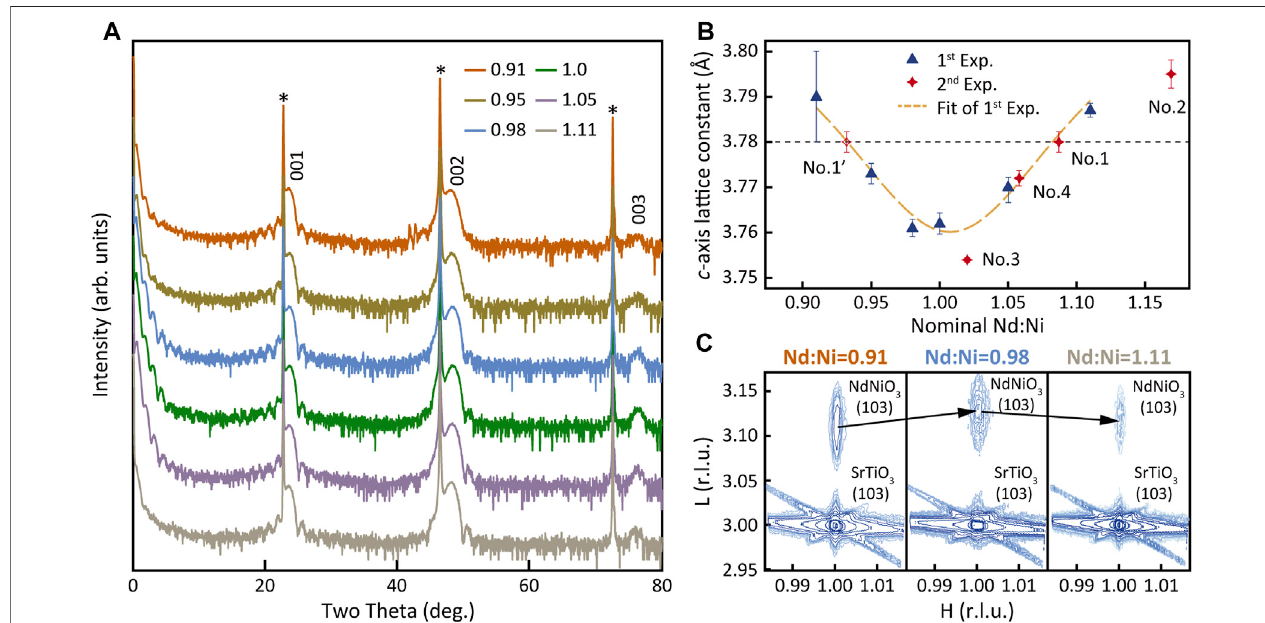
FIGURE 1 | Effect of cation stoichiometry on NdNiO 3 fi lms. (A) XRD 2 θ - ω scans of NdNiO 3 fi lms with different nominal Nd:Ni fl ux ratios. The curves are vertically offsetforclarity. (B) Pseudo-cubiclatticeconstantalongthe( 00l )directionasafunctionofthenominalNd:Ni fl uxratio.Thebluetrianglesandyellowdashedlinerepresent the experimental data and the corresponding Gaussian fi t result, respectively. The red closed stars denote the data points obtained in another set of experiment, accordingtothenumericalordermarkedinthe fi gure,whiletheopenstarisanotherpossiblepositionfortheNo.1sample.Theblackdashedlinedenotesthe c -axis latticeconstantofthe No.1sample.The errorbars come fromthe fi ttingerrorofdiffraction peaks. (C) Reciprocalspacemappings around SrTiO 3 (103) peak forNdNiO 3 fi lms with different fl ux ratios.